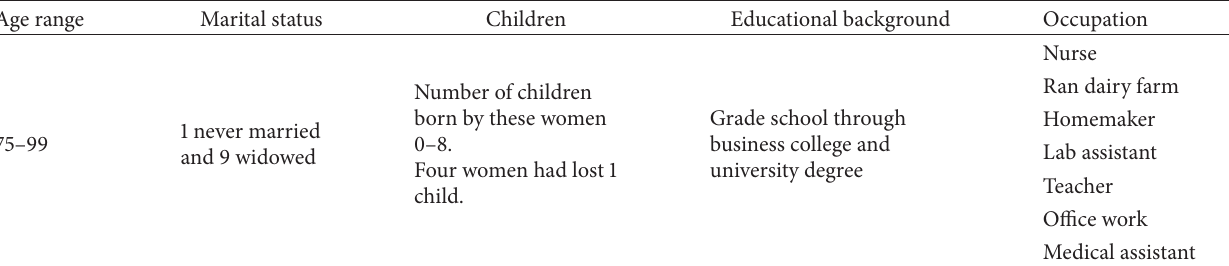
Table 1: Demographic characteristics of study